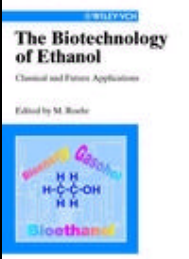
Introduction (M. Roehr). PART I. CLASSICAL METHODS (T. Senn & H. Pieper). Starch Containing Raw